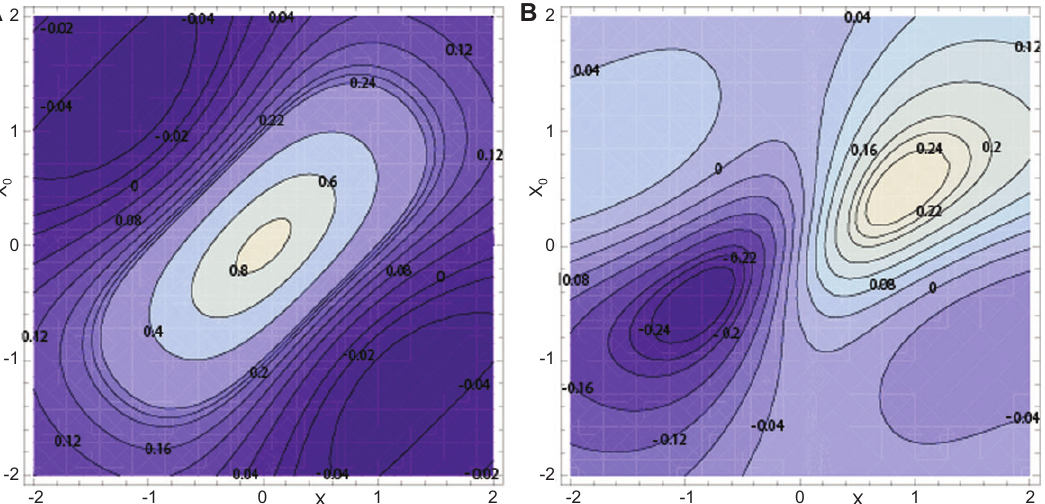
*( ) N v (B) surface displacements due to hole under the action of the α = 0 is a coordinate of applied force. The linear quantities are 0 f λ μ + ( 2 ) N f , is a value of the applied μ λ μ + where N ( )